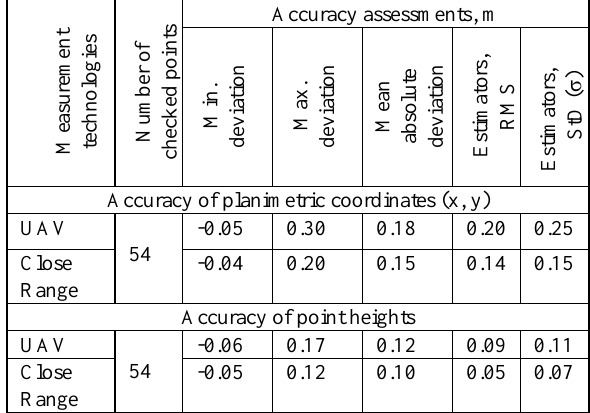
Figure 8 . Fragment of points selected for coordinates checking